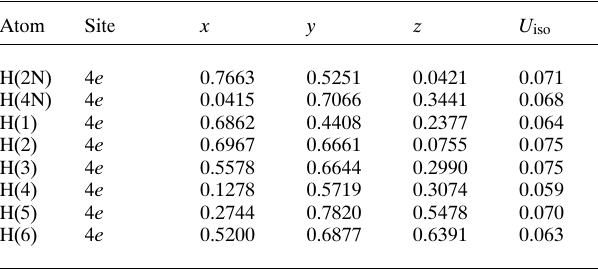
Table 2. Atomic coordinates and displacement parameters (in Å 2 )